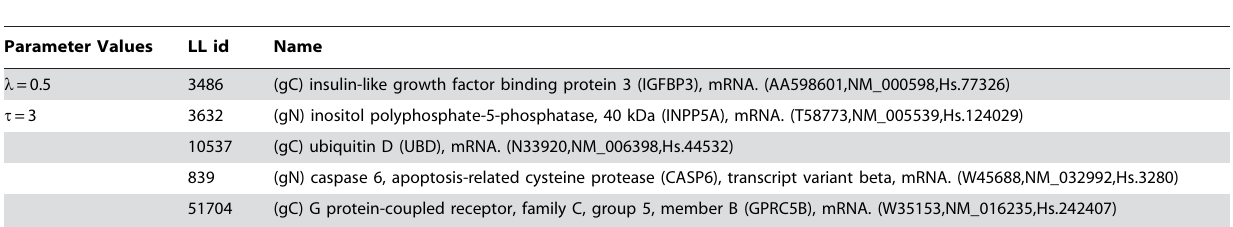
Table 1. Top 5 genes identified by supervised clustering-based model (‘‘simpler method’’).